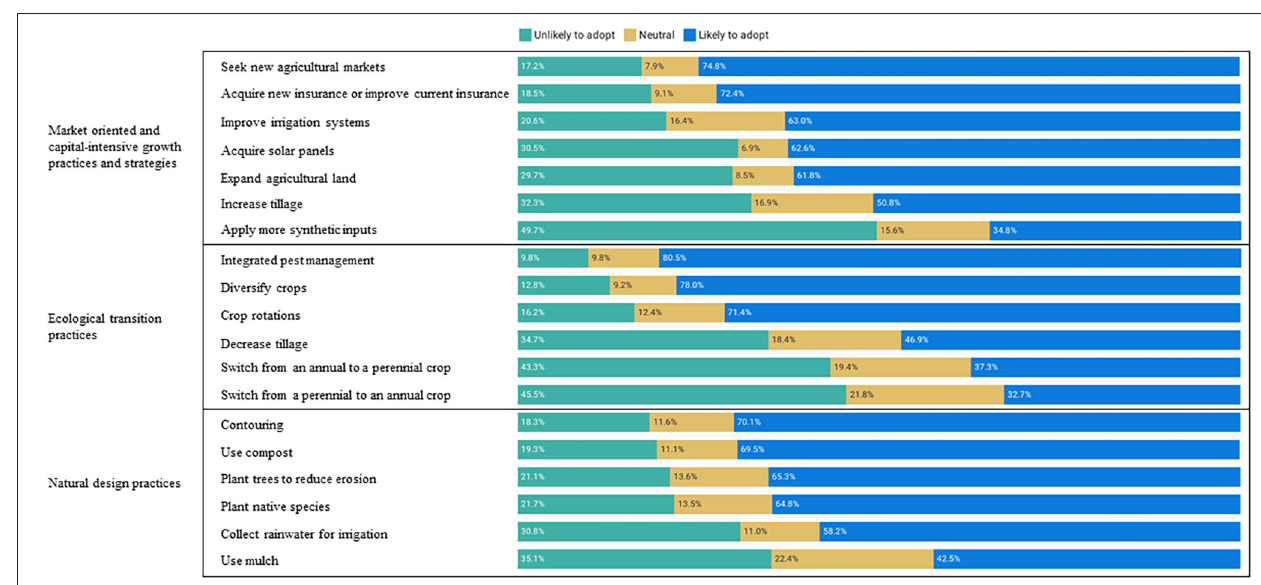
FIGURE 2 | Farmers’ intended adoption of adaptation practices and management strategies after Hurricane Maria.